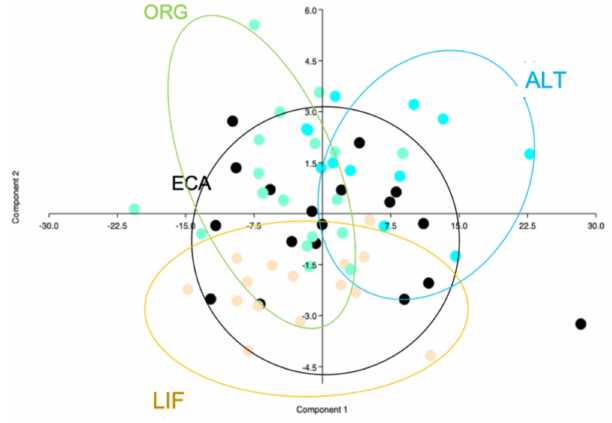
Figure 1. Principal component analysis with physical parameters; component 1 (horizontal axis) and 2 (vertical axis). ALT = alternative with outdoor space, ECA = enriched cage, LIF = litter floor, ORG = organic. IND = only indoor, OUT = outdoor space available.